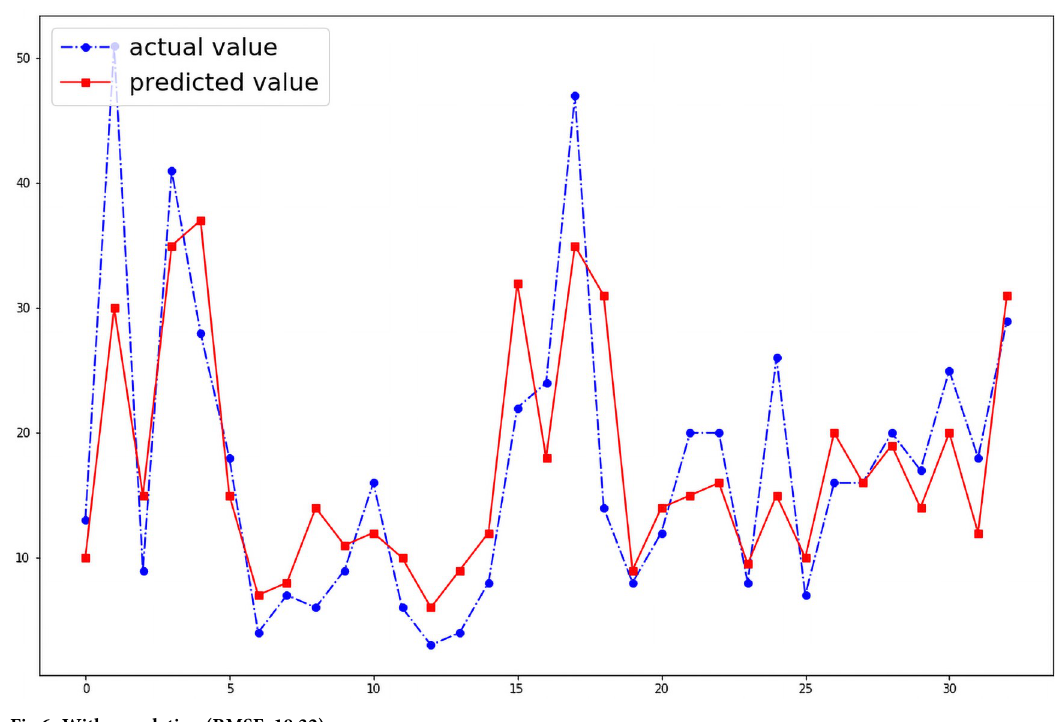
Fig 6. With population (RMSE: 18.32).